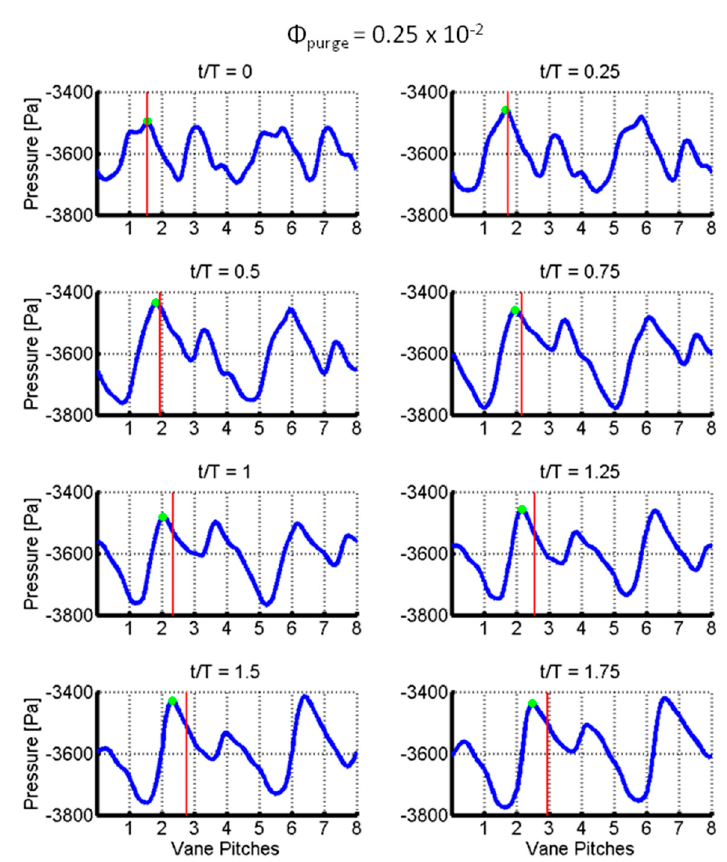
Figure 11. Static pressure across the NGV side rim seal cavity at varying time. The variable t represents the current time, while T represents the time it takes for the rotor to move one blade pitch.